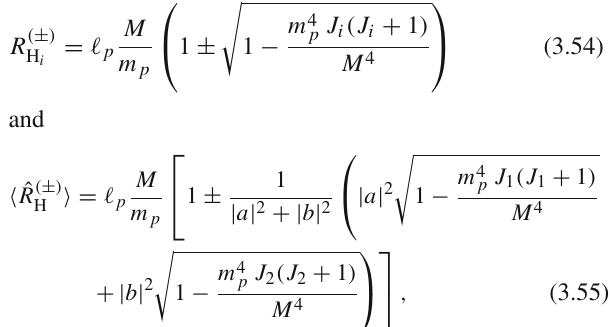
/ 2 λ μ and γ = R ( + ) / 2 λ μ , for a = b = 1 and N = 2 H 1 H 2